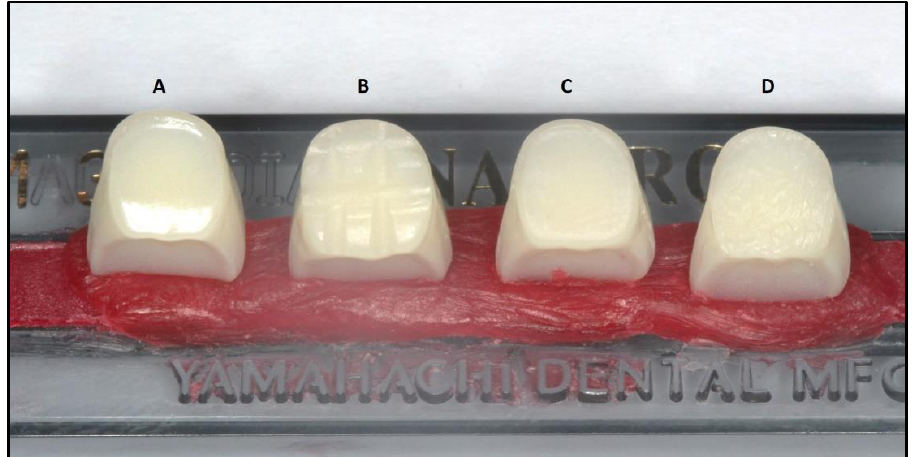
Figure 3. Mechanical treatments performed on teeth: ( A ) No treatment, ( B ) grooves, ( C ) treatment with 50 μm aluminum oxide particles, and ( D ) roughening with a flame-shaped diamond sintered bur.